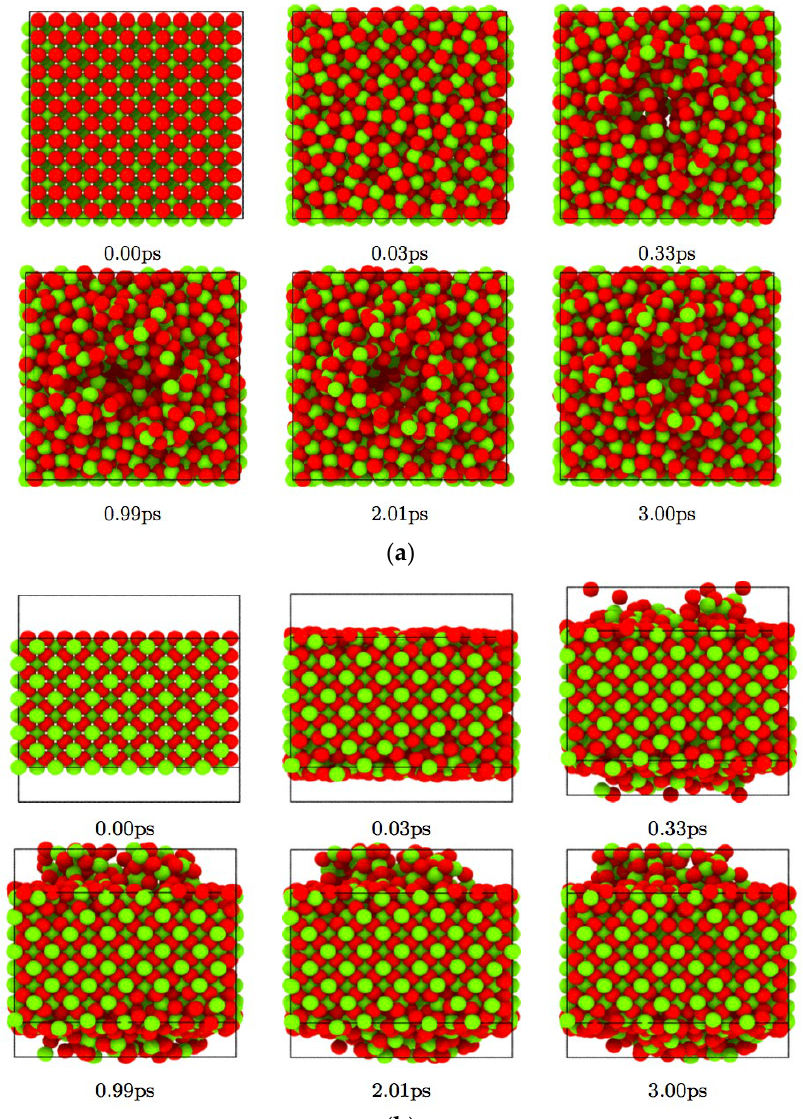
Figure 4. Structural change of the CeO 2 systems viewed from ( a ) <001> and ( b ) <100> directions after the irradiation and for gSe = 0.8 keV/nm.